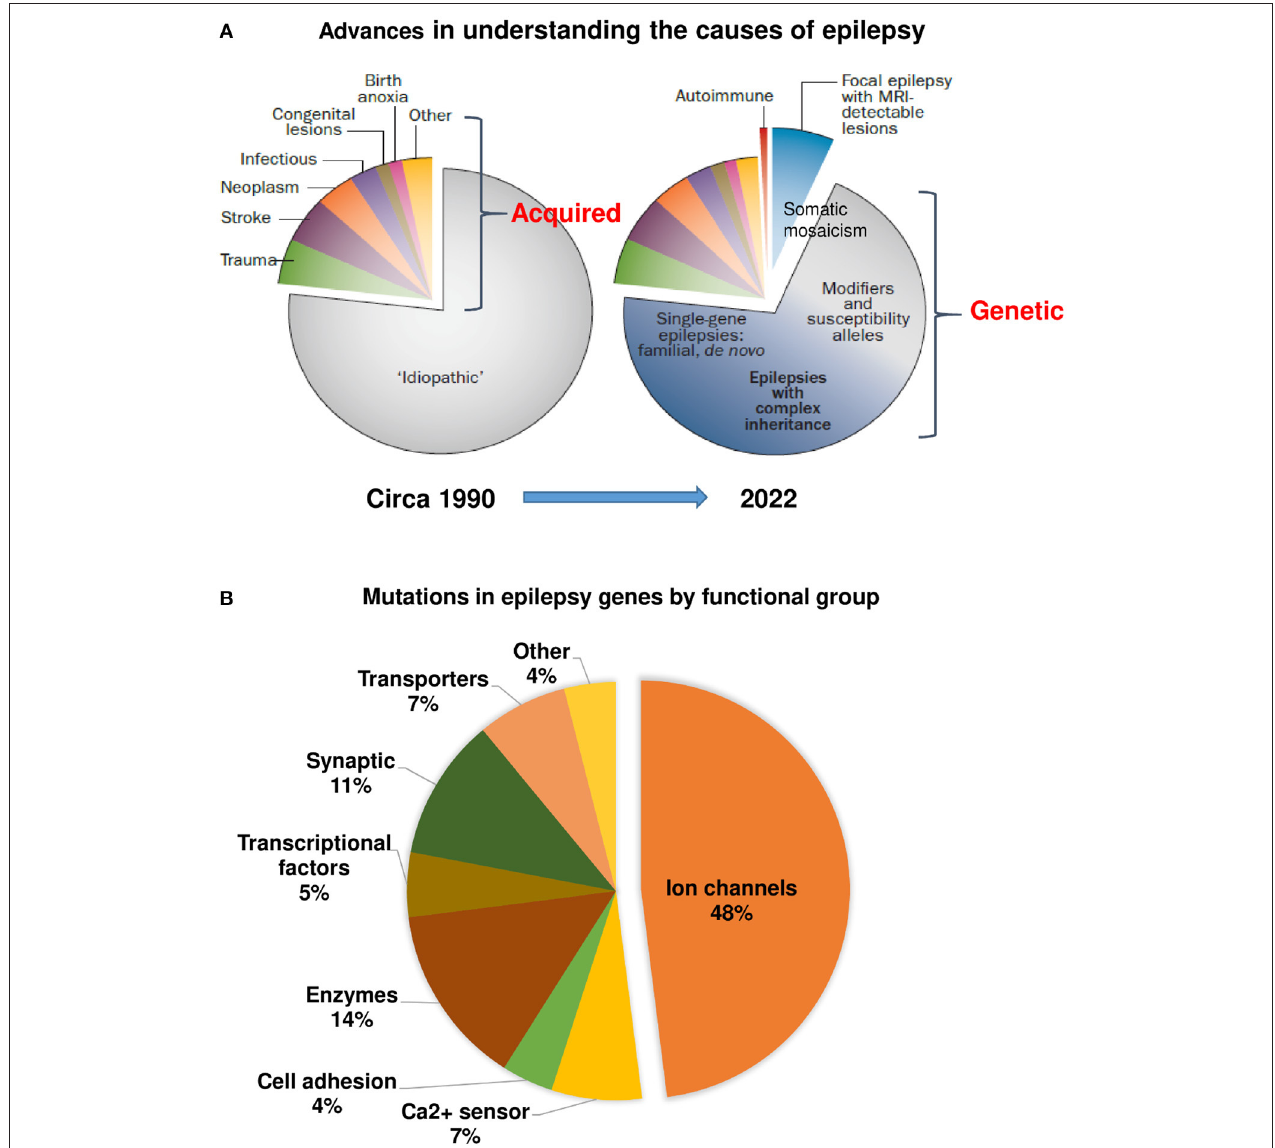
FIGURE 4 | Advances in understanding the causes of human epilepsy. (A) Left graph: Till the ∼ 1990’s, the majority of epilepsies were characterized as “idiopathic.” Right graph: Today, epilepsy of unknown cause comprises a much smaller proportion, owing to the discovery of autoimmune epilepsies, epilepsies with lesions that are only detectable by MRI, and, most importantly, the reclassification of many epilepsies previously considered idiopathic as having a genetic cause. The exact proportions of monogenic and complex or polygenic epilepsies remain uncertain. Based on Thomas and Berkovic (42) and modified recently by Jeff Noebels. (B) Mutations identified in human epilepsy genes by gene function. Modified from Simkin and Kiskinis